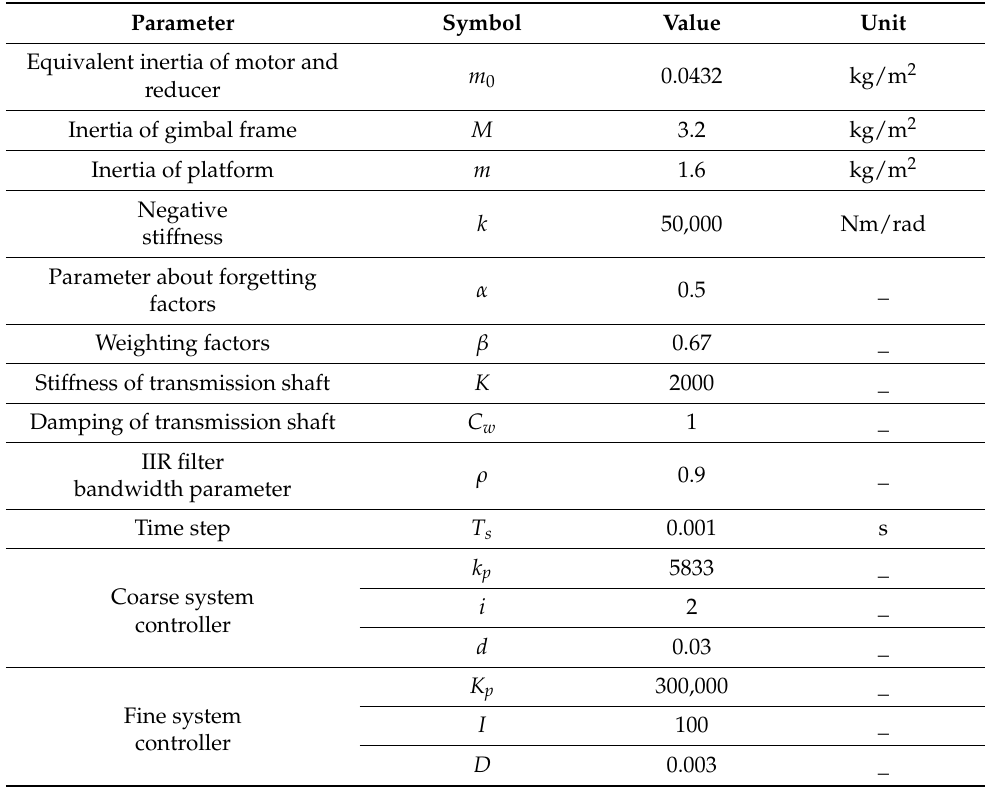
Table 1. System parameters in